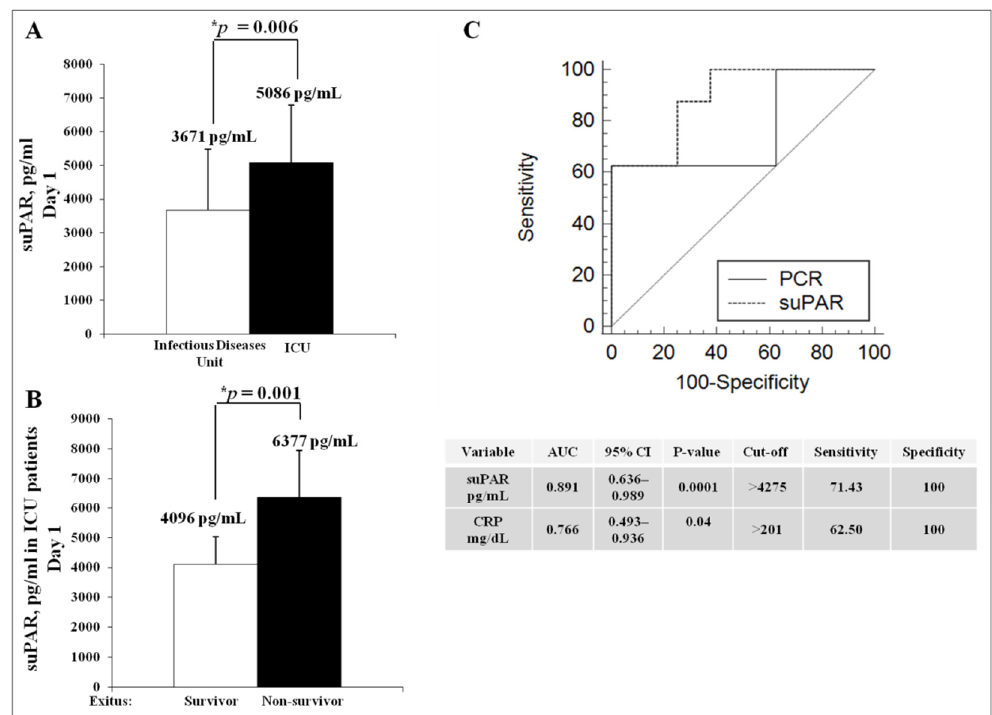
Figure 5. Analysis of serum suPAR levels in severe cases of COVID-19 during the Italian first wave. ( A ) serum suPAR levels in patients hospitalized in Infectious Disease Unit (white column) and ICU (black column). Significant difference between the means of two groups was determined by the Student t -test (* p < 0.05). ( B ) analysis of serum suPAR levels in severe cases of COVID-19 hospitalized in the Intensive Care Unit (ICU) classified in survivors (white column) and non-survivors (black column). Asterisk indicates statistical significance between two groups, determined by the Student t -test (* p < 0.05). ( C ) Receiver Operating Curve (ROC) analysis of CRP and suPAR to define unfavorable outcome in the ICU cohort. Areas under the curve (AUCs), 95% confidence intervals, cut-off, sensitivity and specificity are shown in the